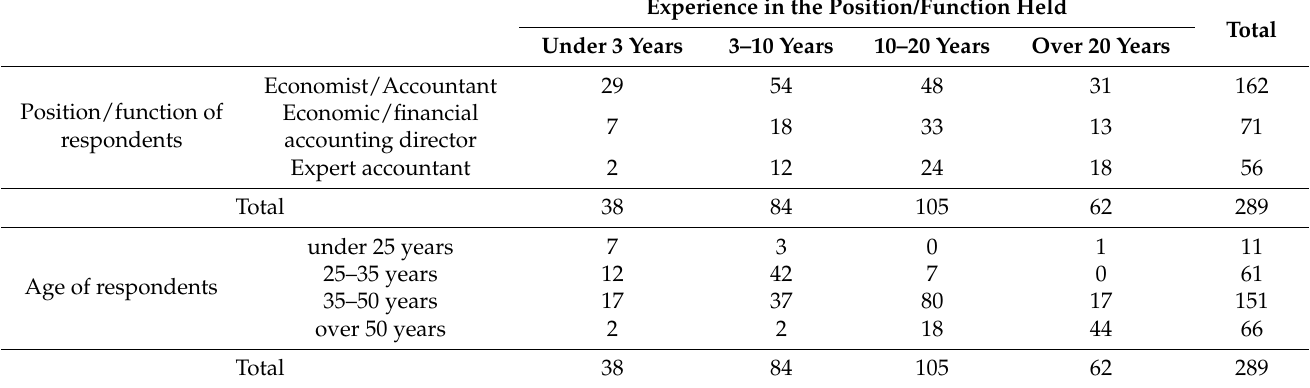
Table 5. Correlation between respondents’ age, position/function, and experience in the posi- tion/function